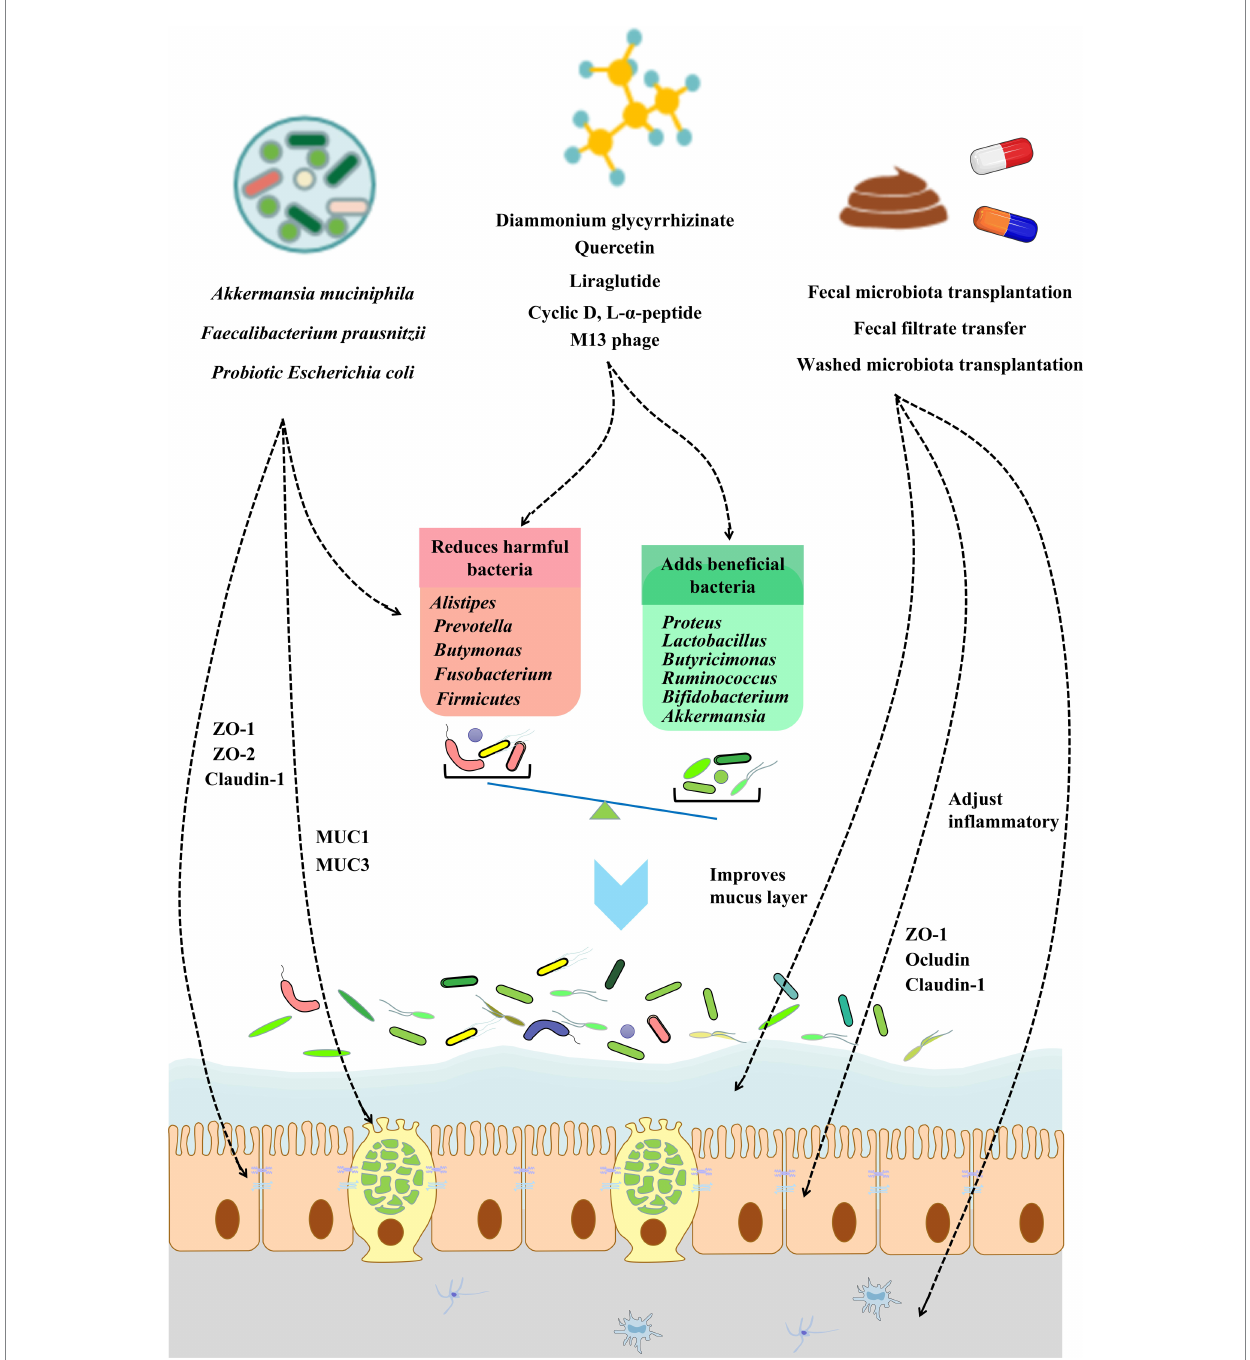
FIGURE 2 The role of modulating gut microbiota in improving gut barrier integrity. The gut barrier can be affected directly or indirectly by the gut microbiota. The modulation of the gut microbiota can occur via probiotics, small-molecule compounds, and fecal transplantation. Restoring the gut microbiota balance can restore gut barrier integrity via gut epithelial cell function and tight junction protein expression, improving the mucus barrier and adjusting inflammatory and inflammation. Further improvements of the intestinal barrier can be used to relieve or treat metabolic